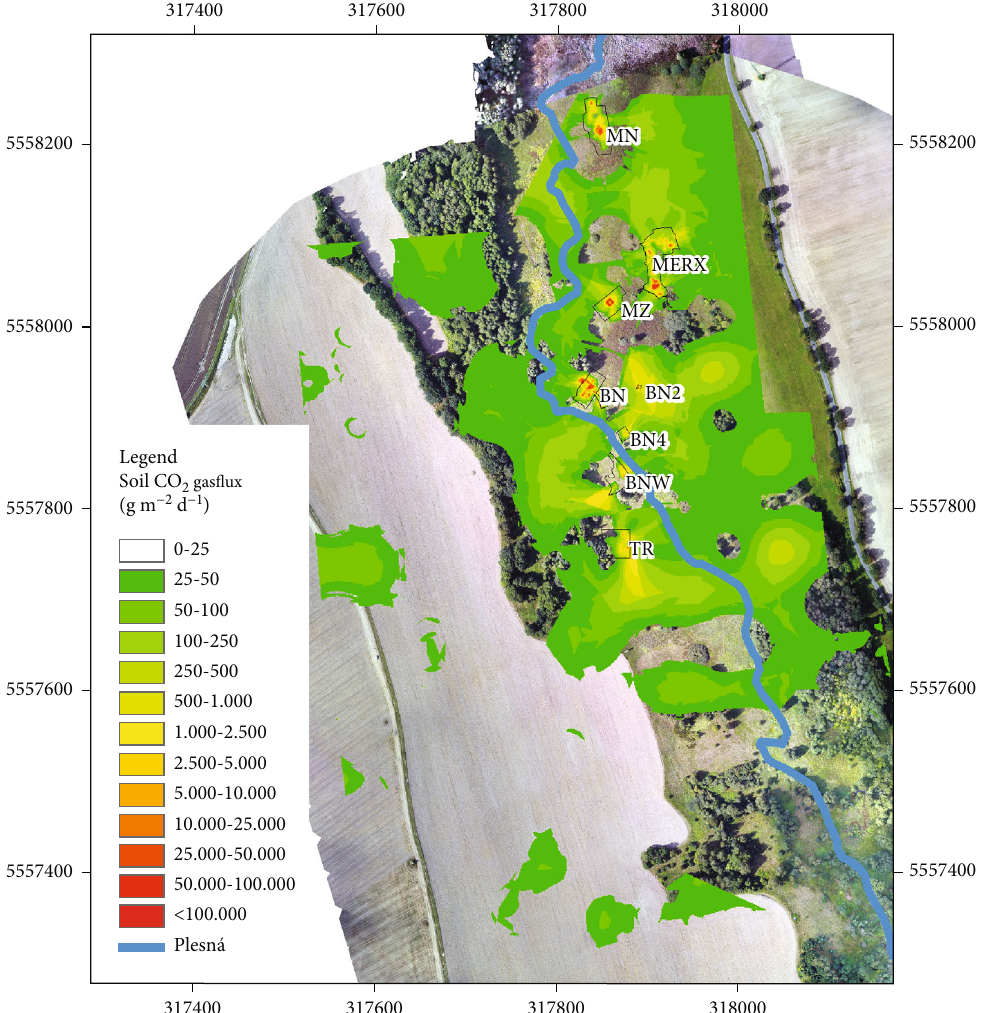
soil gas fl ux for 1m 2 after interpolation of 1.115 measuring points in the Bublák mofette fi eld using trans-Gaussian 2